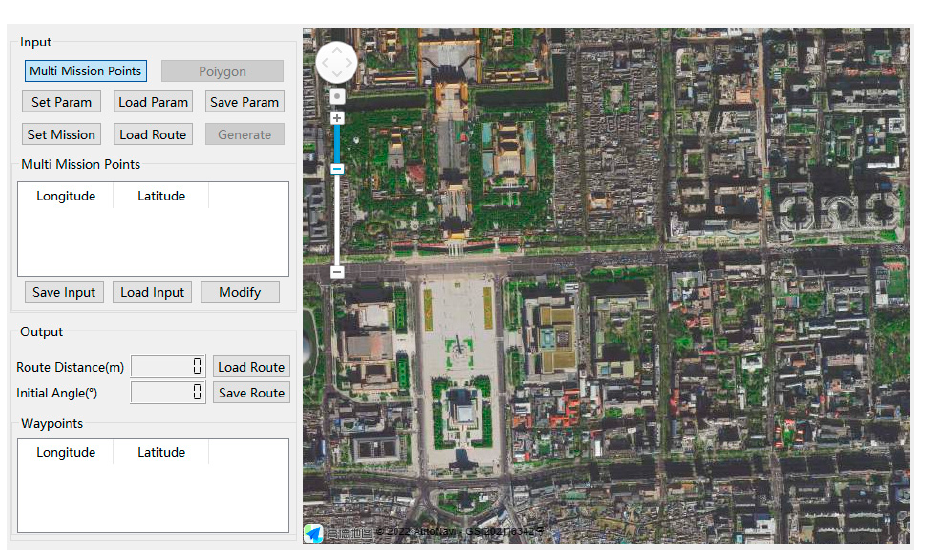
Figure 9. The mission point selection diagram, where the unnumbered point represents the take-off and landing point, and the marked points numbered 1 ~ 9 represent the nine mission points selected in sequence.